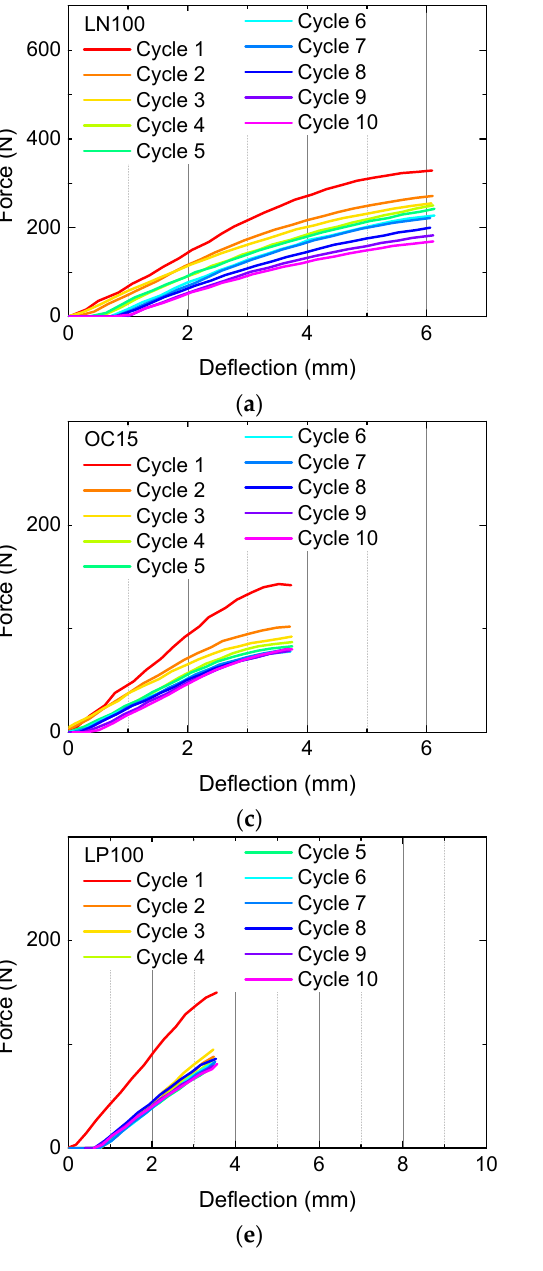
Figure 3. Bending and recovery tests of samples with different infill patterns: ( a ) LN100; ( b ) GY15; ( c ) OC15; ( d ) ZHR100; ( e ) LP100; and ( f ) EW100. Y-axis scales differ. Bending was performed till the deflection at which maximum force occurred, as measured in the previous